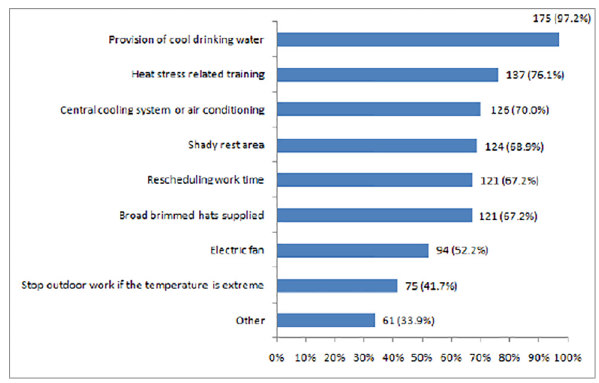
Fig 1. Heat-related preventive measures currently adopted in the workplace.